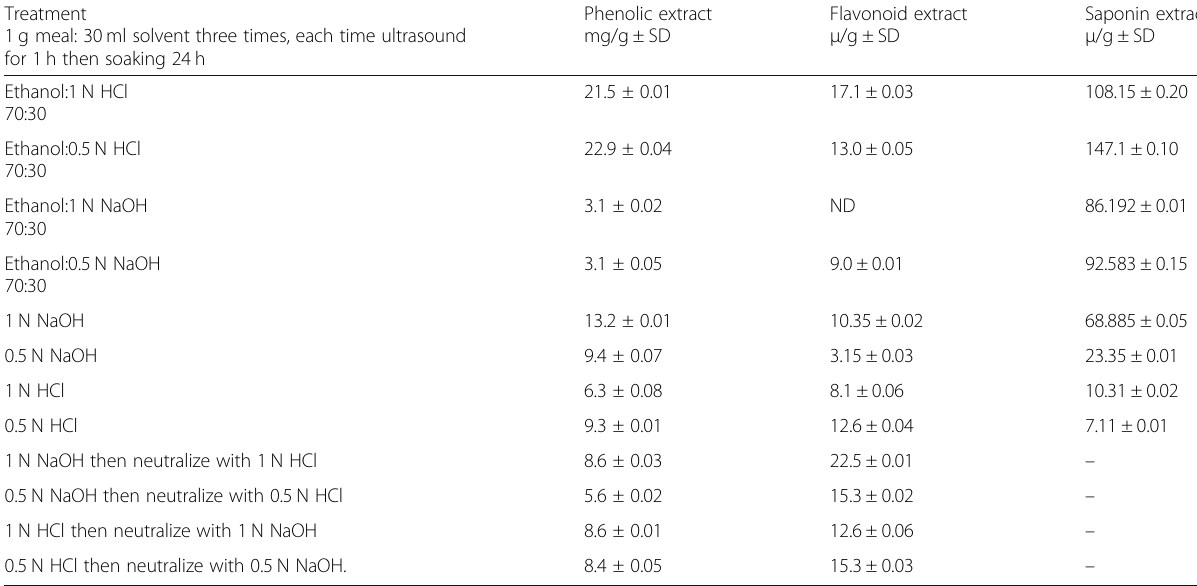
Table 2 Effect of different treatment on the yield of phenolic, flavonid, and saponin compounds extracted from jatropha hulls at room